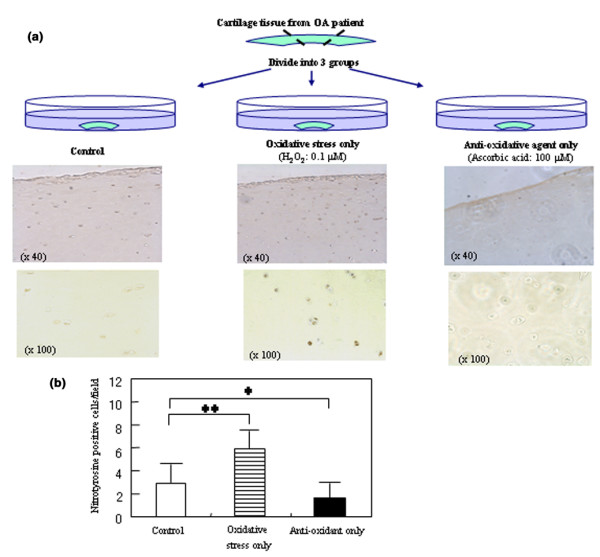
Tissue culture of articular cartilage tissue. (a) Representative immunohistochemical staining for nitrotyrosine in cartilage explants treated with reactive oxygen species (ROS) or an antioxidative agent in tissue culture. Osteoarthritis (OA) cartilage explant from a 67-year-old donor was cut and divided into three groups: control group, H2O2 treated group, and antioxidative agent (ascorbic acid-2-O-phosphate [Asc2P]) treated group. After the end of the incubation period (48 hours of incubation), the cartilage sections were immunostained with anti-nitrotyrosine antibody. Original magnifications are given in parentheses. (b) The number of nitrotyrosine positive cells were counted in the 20 areas of tissue-cultured cartilage at 200× magnification (0.785 mm2/field). A statistical analysis of immunostaining was performed. *P < 0.05, **P < 0.01, versus control group.